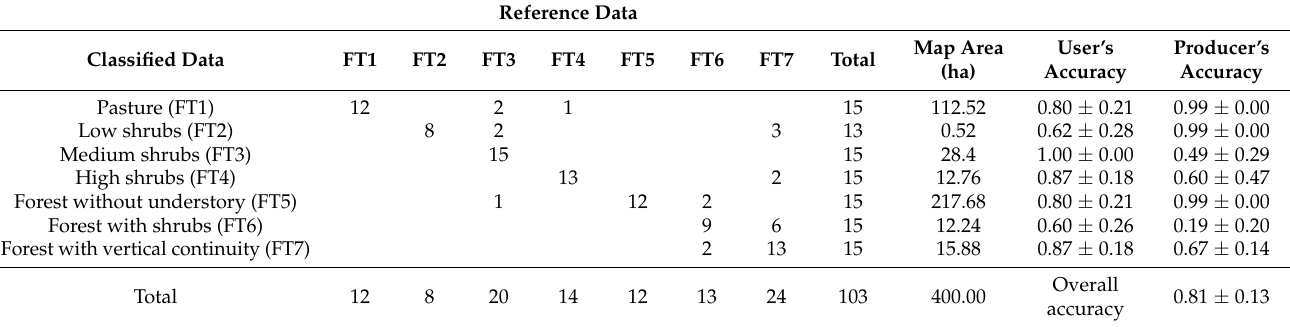
Table 4. Error matrix corresponding to the 2016 dataset. Accuracy measures are presented with a 95% confidence